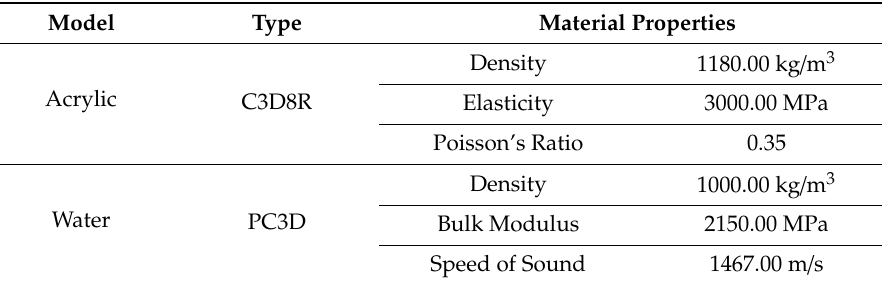
Figure 4. Finite element model for validation analysis. Table 2. Summary of elements and materials applied to validation analysis.